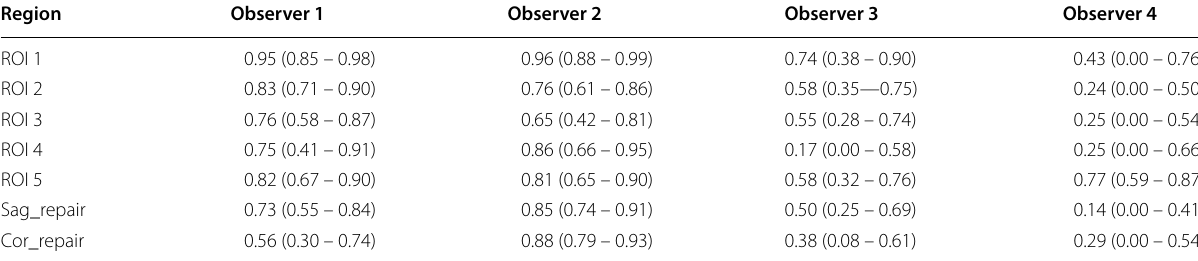
Intraobserver agreement for T2 measurements of native cartilage and repair cartilage tissue. ROI (Region of Interest) 1 and 2: sagittal plane, medial and lateral condyles, respectively. ROI 3: mid-sagittal, patella. ROI 4 and 5: coronal plane, medial and lateral condyles, respectively. Sag_repair and Cor_repair: sub-regions of repair tissue on sagittal and coronal images, respectively